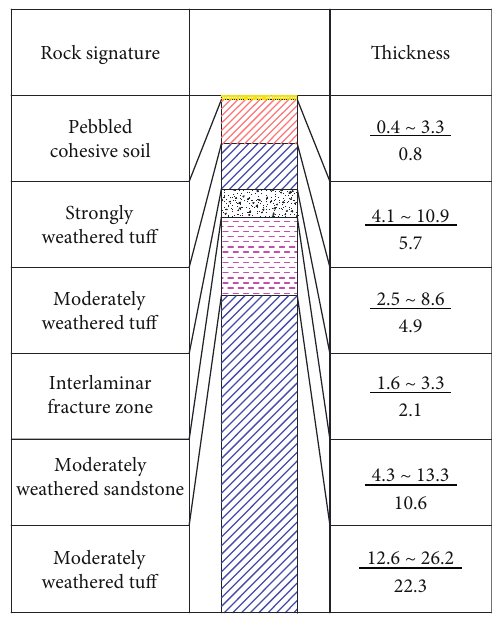
Figure 3: Histogram of stratigraphic